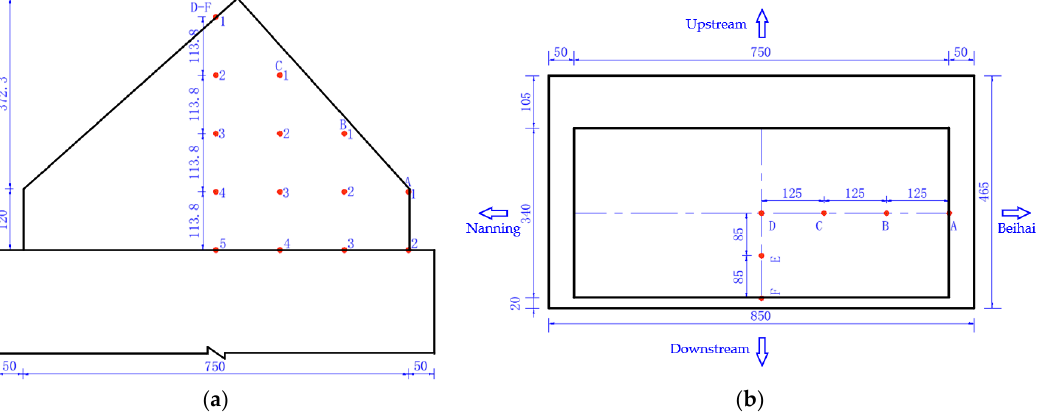
Figure 10. The arrangement of temperature monitoring points for mass concrete in arch abutment: ( a ) elevation; ( b ) Plan. (Unit: cm).